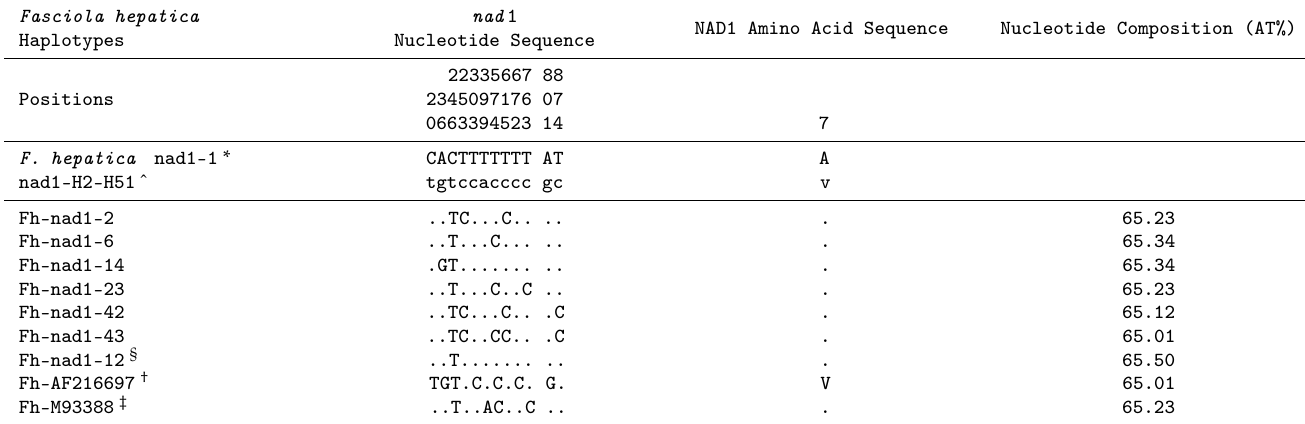
Table 6. Nucleotide sequence (903 bp-long) and protein sequence (300 aa-long) of the complete mtDNA nad 1 gene of Fasciola hepatica populations studied from Ecuador compared to other haplotypes of the same species. Positions = numbers (to be read in vertical) refer to variable positions obtained in the alignment made with MEGA 7.0; . =